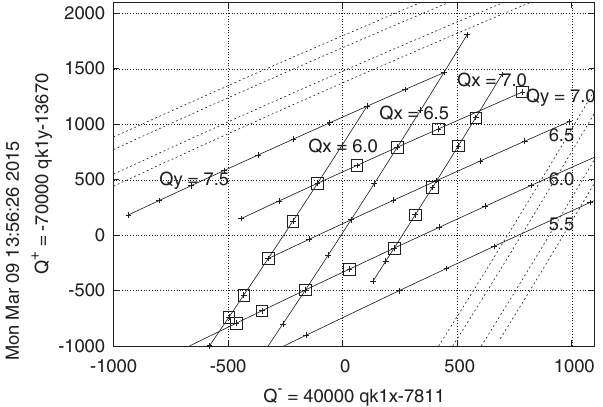
FIG. 3. Tune plane resonance diagram as calculated by TEAPOT , with bend elements treated as magnetic. There is good qualitative and quantitative agreement with the Courant data shown in Fig. 2.